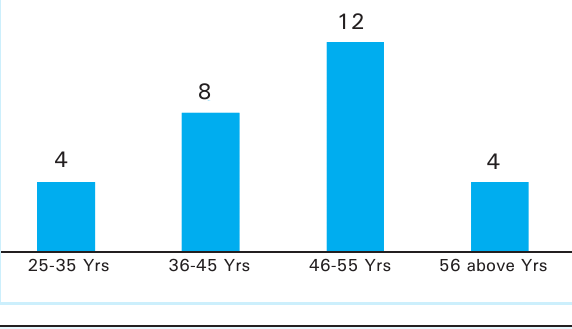
Figure 1. Bar diagram showing distribution of patients according to age group.